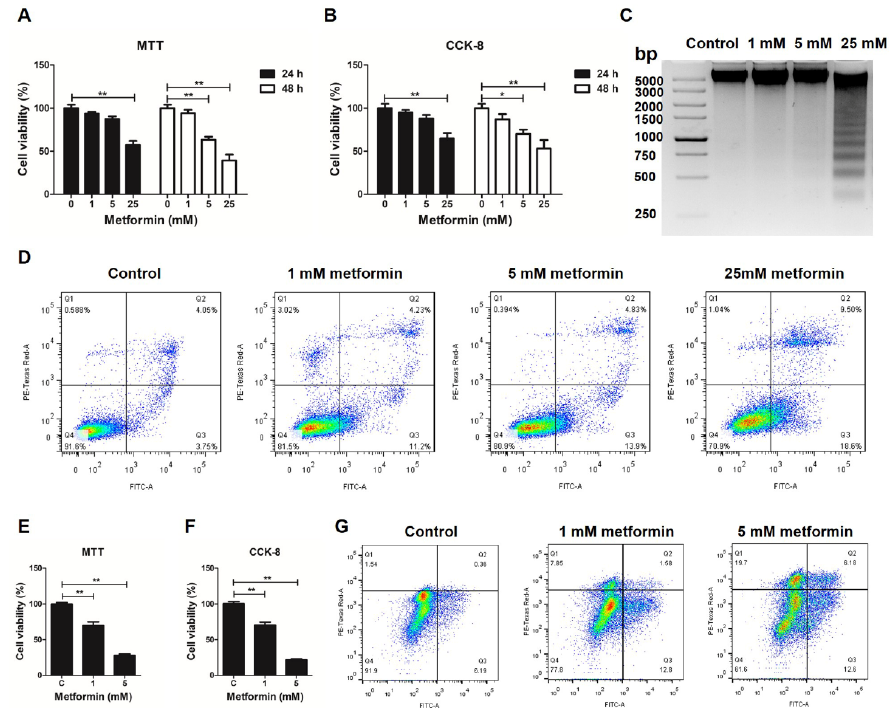
Figure 1. The influence of metformin on cell proliferation and apoptosis in macrophages. MTT ( A ) and CCK-8 ( B ) assays were performed to analyze the cell proliferation of HD11 cells treated with metformin for 24 and 48 h. ( C ) Apoptotic DNA ladder detection for HD11 cells treated with metformin for 48 h. ( D ) Metformin-induced apoptosis in HD11 cells by flow cytometry. The X axis represents Annexin V-FITC, and the Y axis represents propidium iodide (PI). MTT ( E ) and CCK-8 ( F ) assays were performed to analyze the cell proliferation of RAW264.7 cells treated with metformin for 48 h. ( G ) Metformin-induced apoptosis in RAW264.7 cells by flow cytometry. The X axis represents Annexin V-FITC, and the Y axis represents PI. Q1 represents necrotic cells, Q2 represents late apoptotic cells, Q3 represents early apoptotic cells, and Q4 represents normal cells. * represents p < 0.05 and ** represents p < 0.01.